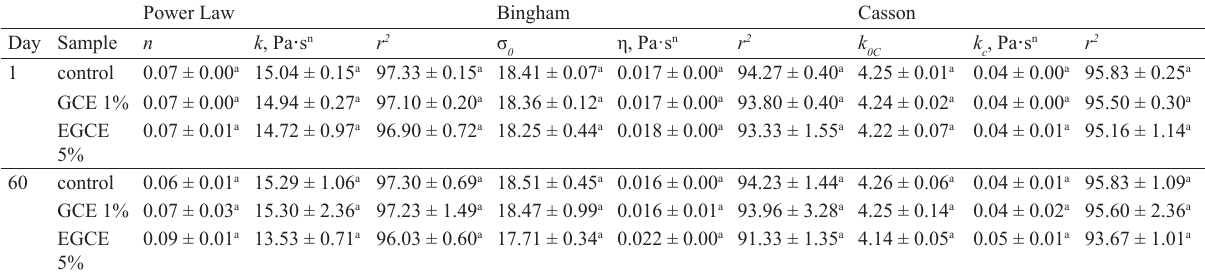
Table 4 Effects of storage on some model parameters of control, GCE 1%, and EGCE 5% samples Power Law Bingham